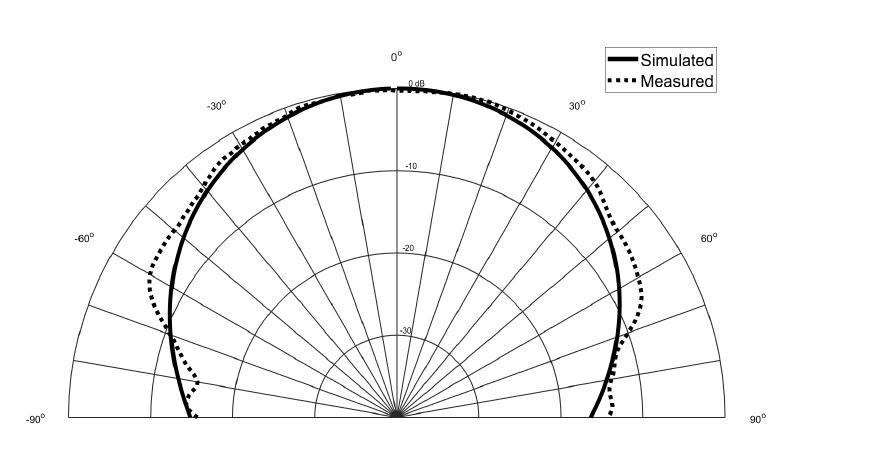
Figure 15. Simulated and measured radiation pattern of the circular patch antenna.